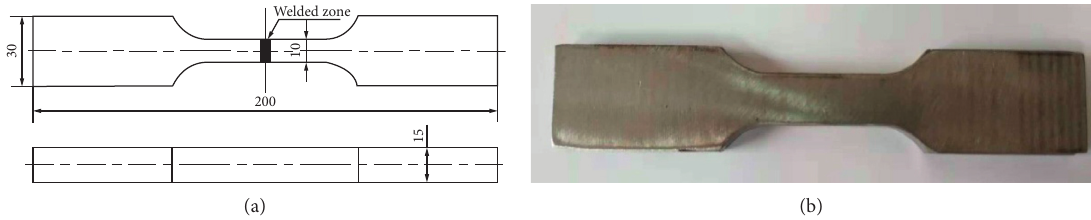
Figure 14: Geometry of the welded steel specimen. (a) Geometry of the weldment (unit: mm). (b) Welded specimen.